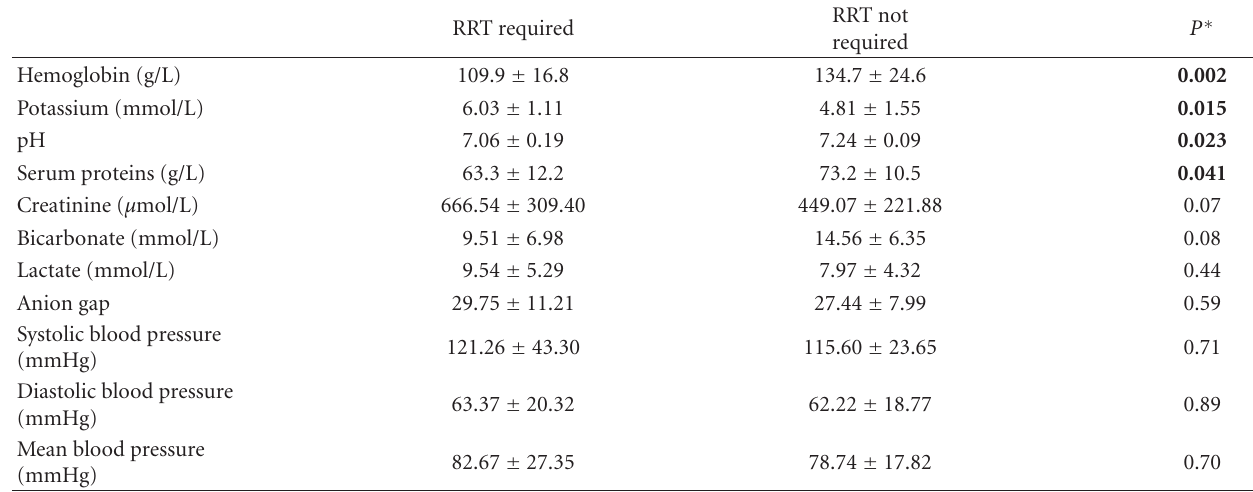
Table 2: Prognostic factors for renal replacement therapy